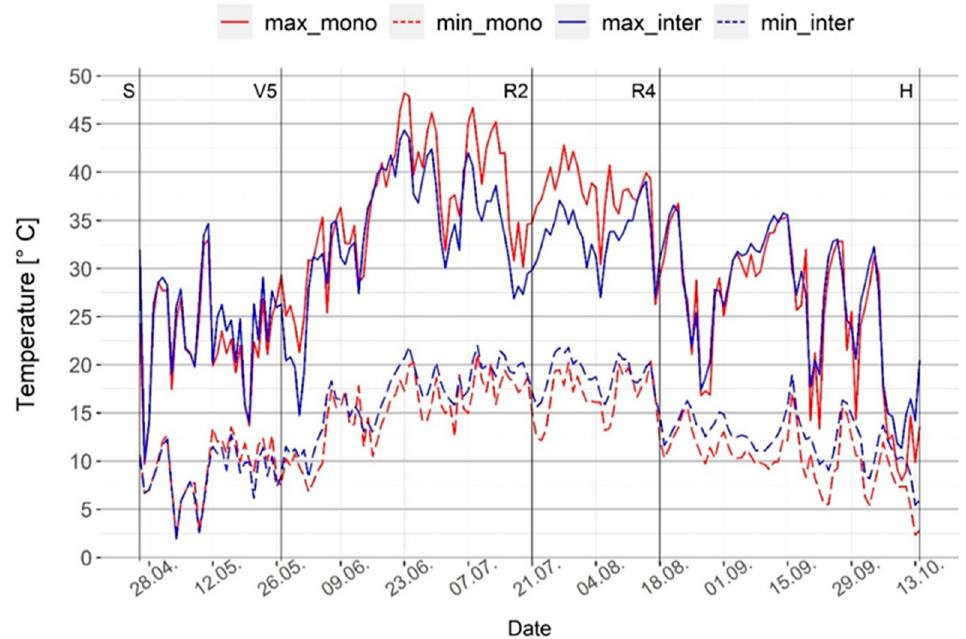
Figure 2. Daily temperature range (minimum and maximum) inside maize rows in the monoculture and intercropped systems. S—maize sowing date; V5—maize five leaves stage; R2—maize blister stage; R4—maize dough stage; H—maize harvest.